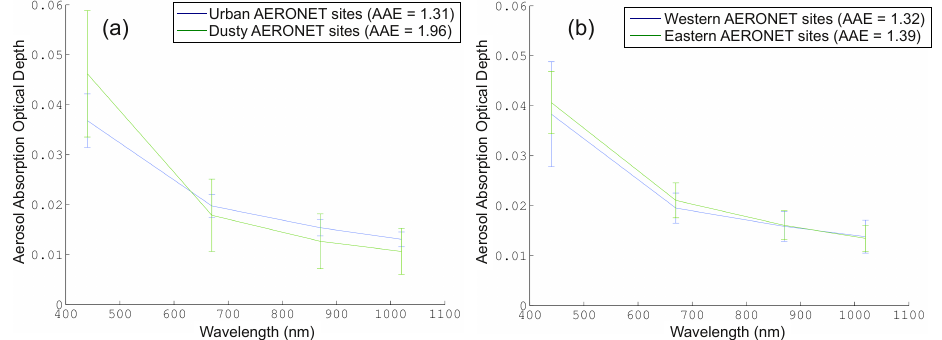
Fig. 7. Wavelength dependence of Aerosol Absorbing Optical Depth (AAOD) for Urban-Industrialised and Dusty AERONET sites (a) and for Western and Eastern AERONET sites (b) . Associated standard deviations and mean AAE (calculated between 440 and 880nm) are also reported